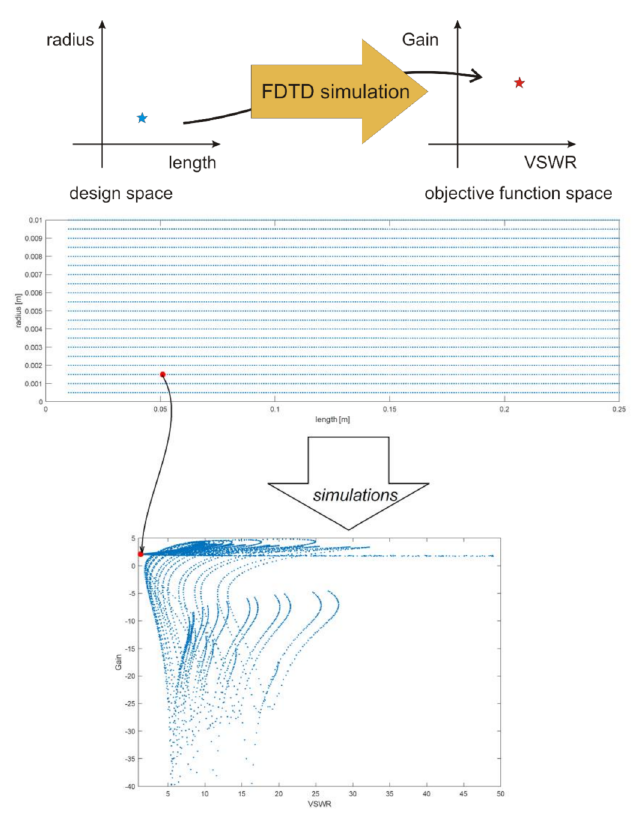
Figure 4. Design parameter space ( L.r ) and objective function component space ( VSWR. G ) for dipole